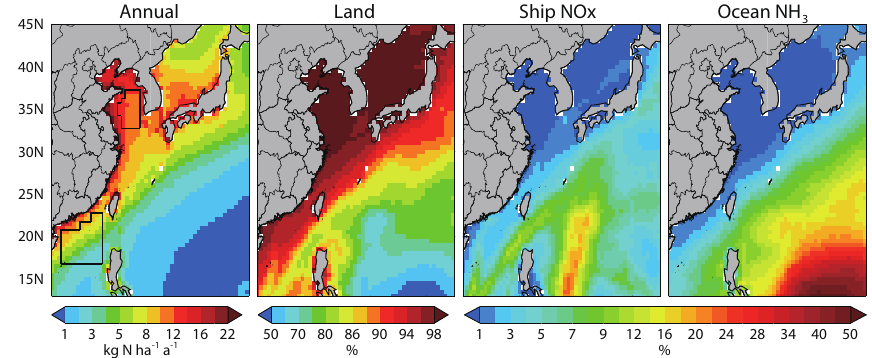
Figure 8. Annual total nitrogen deposition fluxes to the northwestern Pacific averaged in 2008–2010 (first panel), and annual percentage contributions from nitrogen sources over land, ship NO x emissions, and oceanic NH 3 emissions.